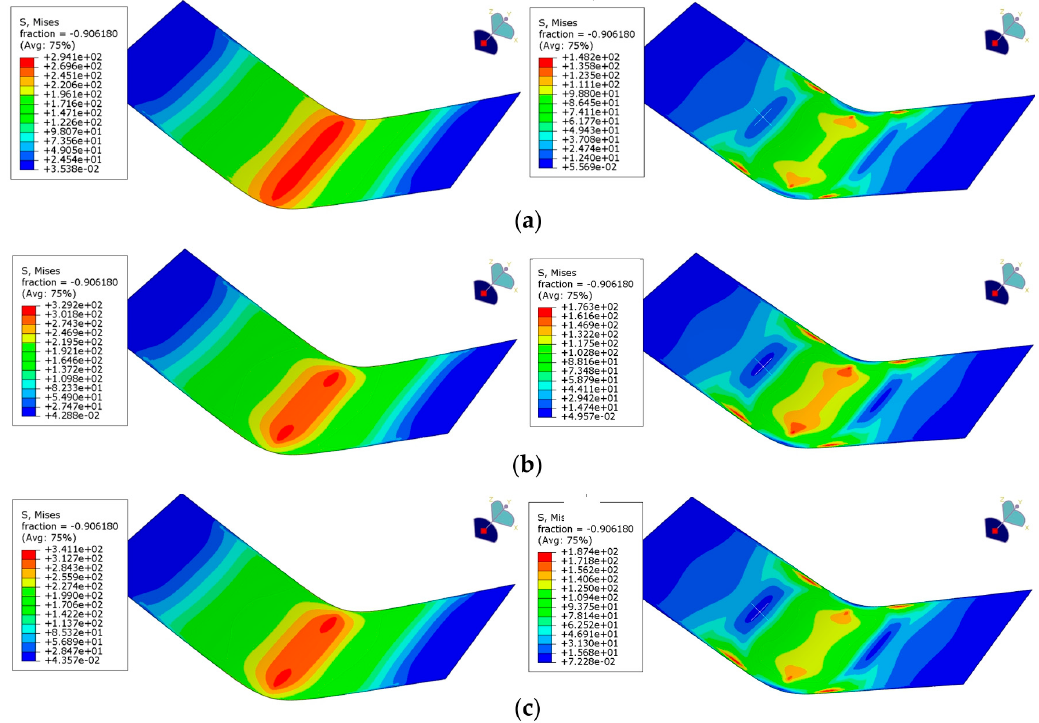
Figure 11. The HMH stress distribution (left) under loading and (right) after unloading, for ( a ) samples with isotropic material and ( b ) anisotropic material oriented at 0° and ( c ) 90°, for a punch depth under loading of 18 mm.